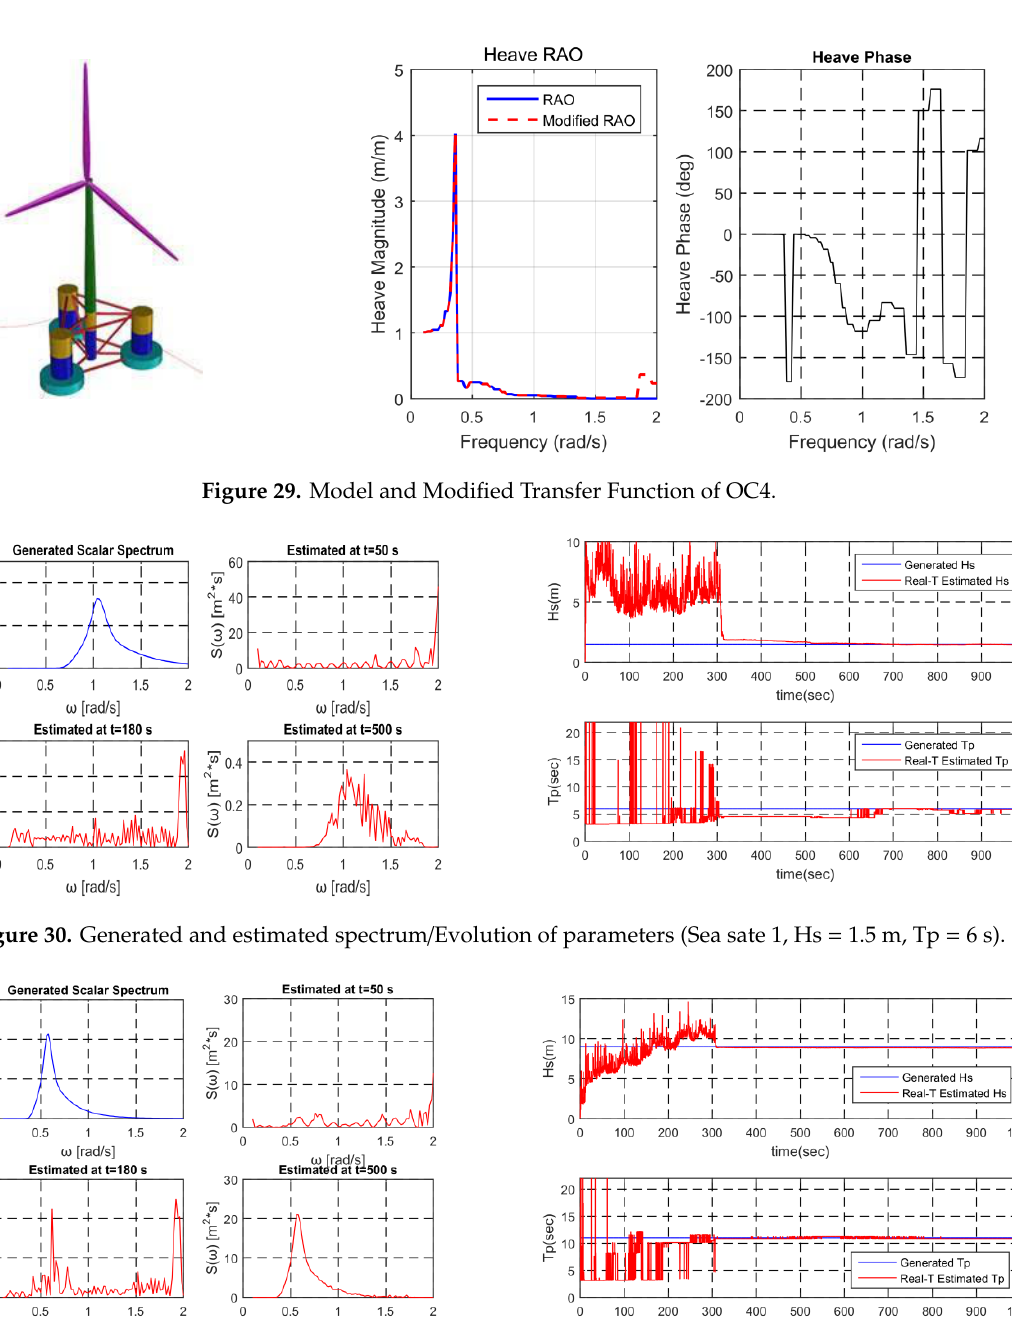
Figure 32. Generated and estimated spectrum/Evolution of parameters (Sea sate 5, Hs = 17 m, Tp = 15 s). Up to this point, the developed Kalman-filter algorithm has been applied to the stationary sea state. However, sea states continue to change in actual sea, so, it is of interest to inversely estimate waves for non-stationary seas. The sea state sequence is set as shown in Table 3, which is taken from a series of sea states along the dotted line from Jacksonville, Florida to the ‘NA’ point in Figure 2. It is assumed that the sea state is changing accordingly. The sensor error’s standard deviation was set as 2.3 cm and the modified TF was applied to the FPSO. Simulation was performed assuming that the vessel’s motion continuously varies due to the changes in sea state. The superposed motion time series for each sea state were then connected in order (Figure 33). Table 3. Simulated sea state sequence along the route. Sequence